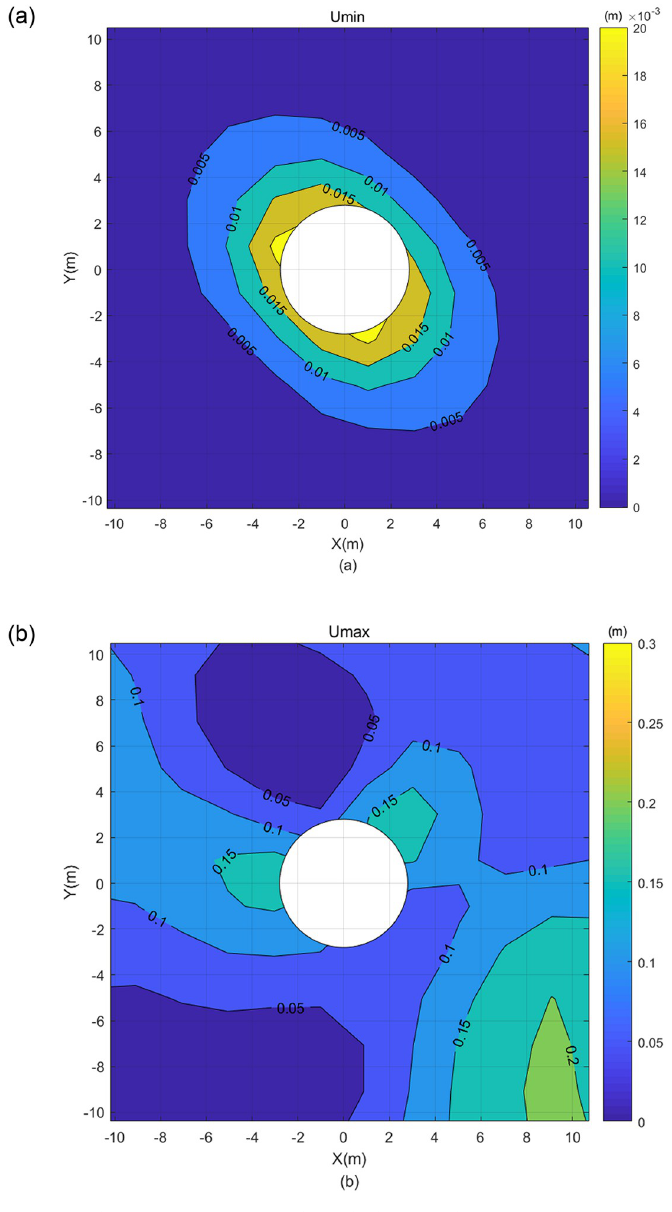
Fig 9. Displacement contour map after calculation with rearranged grey matrix—(a) Umin and (b) Umax. operation properties of grey number, the lower bound of each element obtained is less than the upper bound. However, when the element stiffness matrix with grey variables is calculated, the lower bound of some elements becomes greater than the upper bound. The load matrix with grey variables also has the same problem. By rearranging the elements of the stiffness matrix with grey variables and the load matrix with grey variables with the rule that the lower bound is smaller than the upper bound, and calculating with Eq (31), the results can be derived as the displacement contour map in Fig 9.